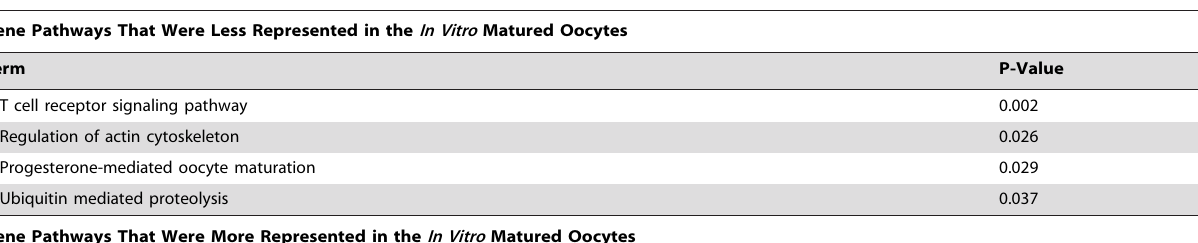
Table 1. David gene pathways that were mis-represented in the in vitro matured oocytes.